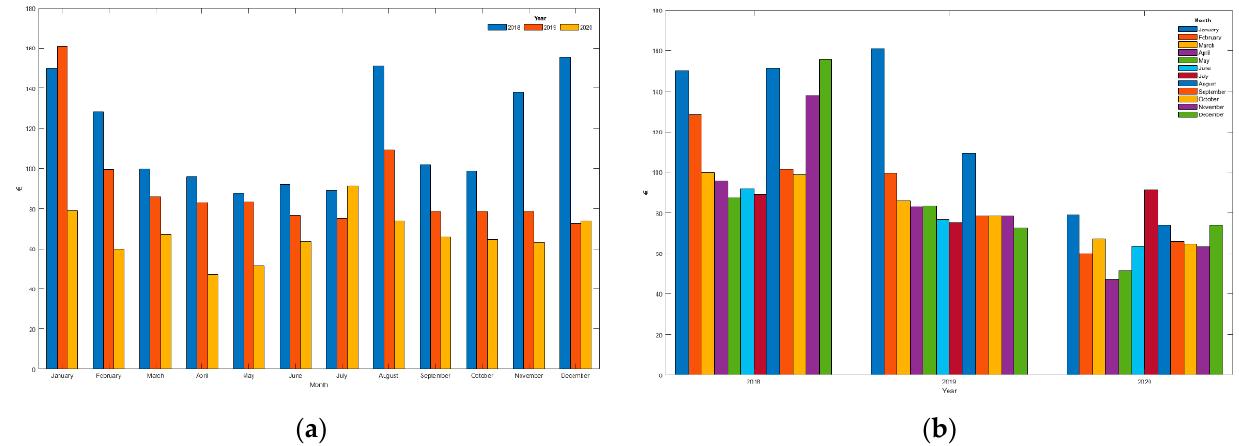
Figure 24. ( a ) For each month, a comparison of the amount of the electricity bill (€) is sorted by year. ( b ) For each year, a comparison of the amount of the electricity bill (€) is sorted by month.